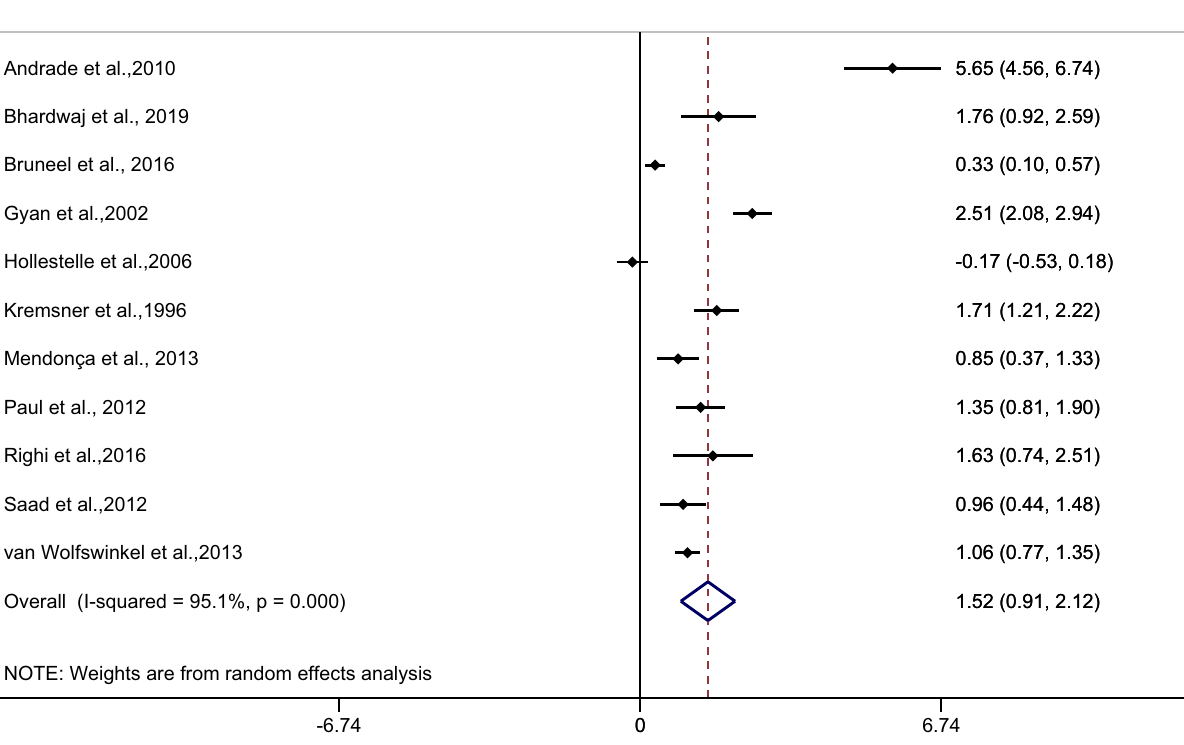
Figure 2. Forest plot demonstrates the difference in the mean CRP level between patients with severe and uncomplicated malaria. SMD, standard mean difference; CI, confidence